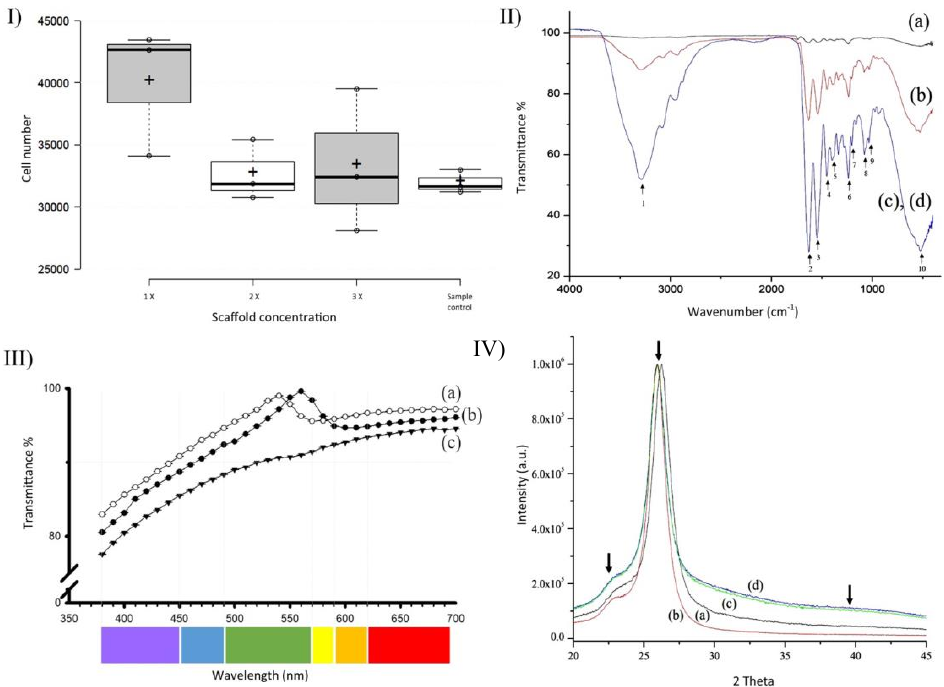
Figure 5. ( I ) Cell adherence. NIH3T3 cell count at 48 h when cultured over 1X, 2X, and 3X collagen membranes. Sample control lacks collagen membrane. ( II ) IR spectra of pure collagen type 1 (a), 1X collagen membranes (b), 2X collagen membranes (c), and 3X collagen membranes (d). ( III ) Transmittance . Percent of transmittance of membranes fabricated using varying collagen volumes: 1X (a), 2X (b), and 3X membranes (c). ( IV ) X-ray diffraction. Patterns of pure collagen type 1 (a), 1X (b), 2X (c), and 3X collagen (d) membranes. A 0.6° offset was introduced to detect each pattern clearly. The arrows indicate the 22°, 25.9°, and 39.8° humps for amorphous collagen and the two hydroxyapatite planes.